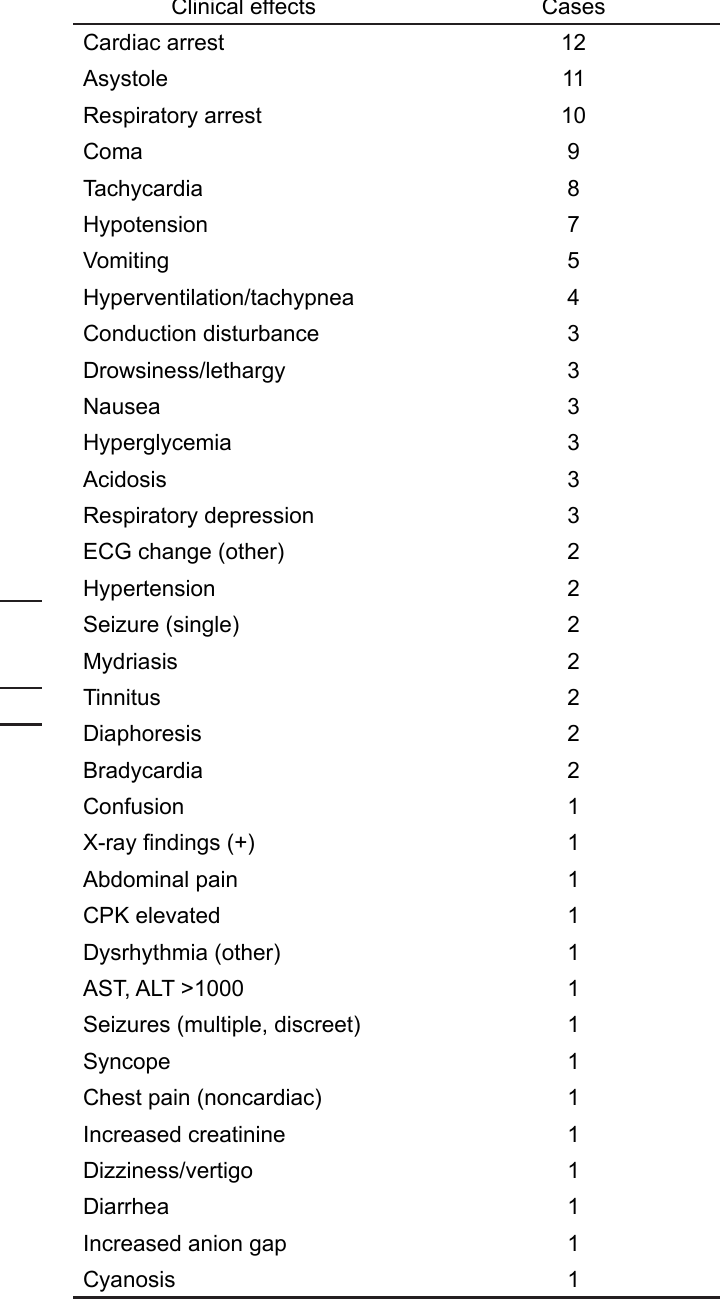
Table 4. Clinical effects reported in death